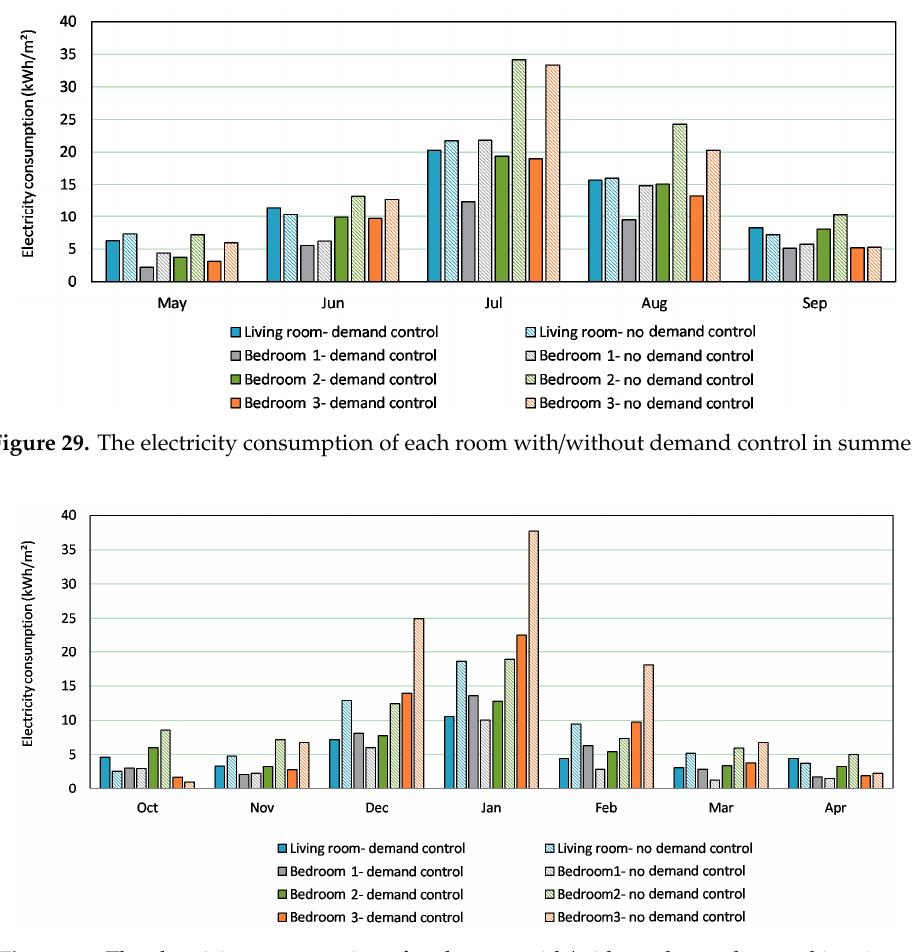
Table 5. Total electricity consumption of the house and demand-control energy-saving